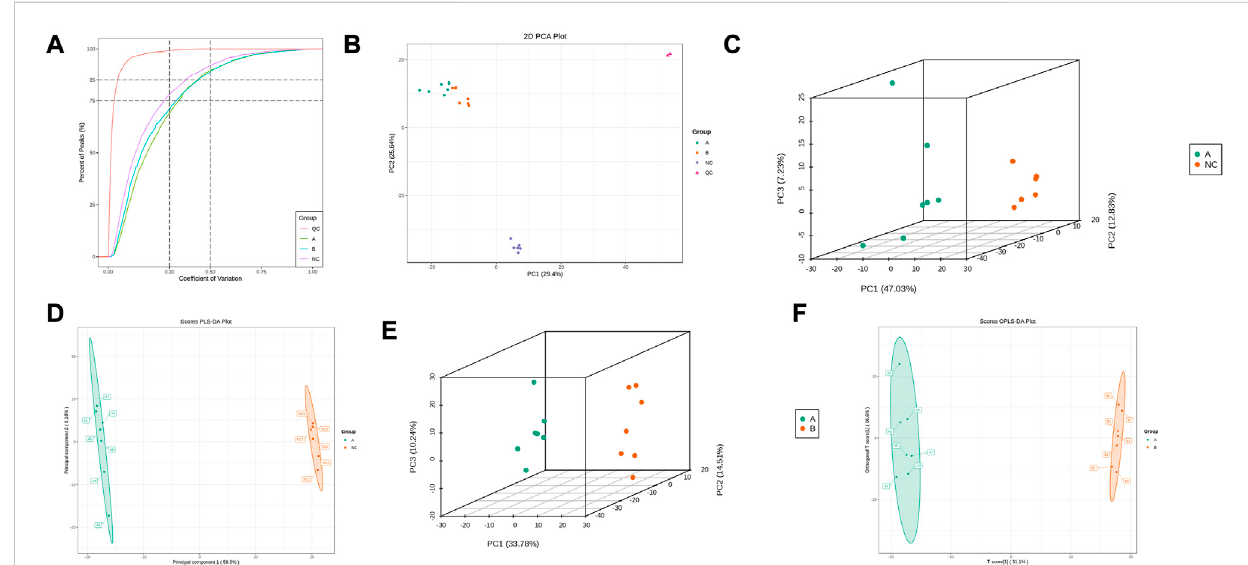
FIGURE 3 Metabolic Pulmonary Analysis. (A) CV distribution of each group of samples; (B) PCA score of each group of samples with mass spectral data of QC samples; (C) PCA score between A and NC; (D) OPLS-DA analysis between A and NC; (E) PCA score between A and B; (F) OPLS-DA analysis between A and